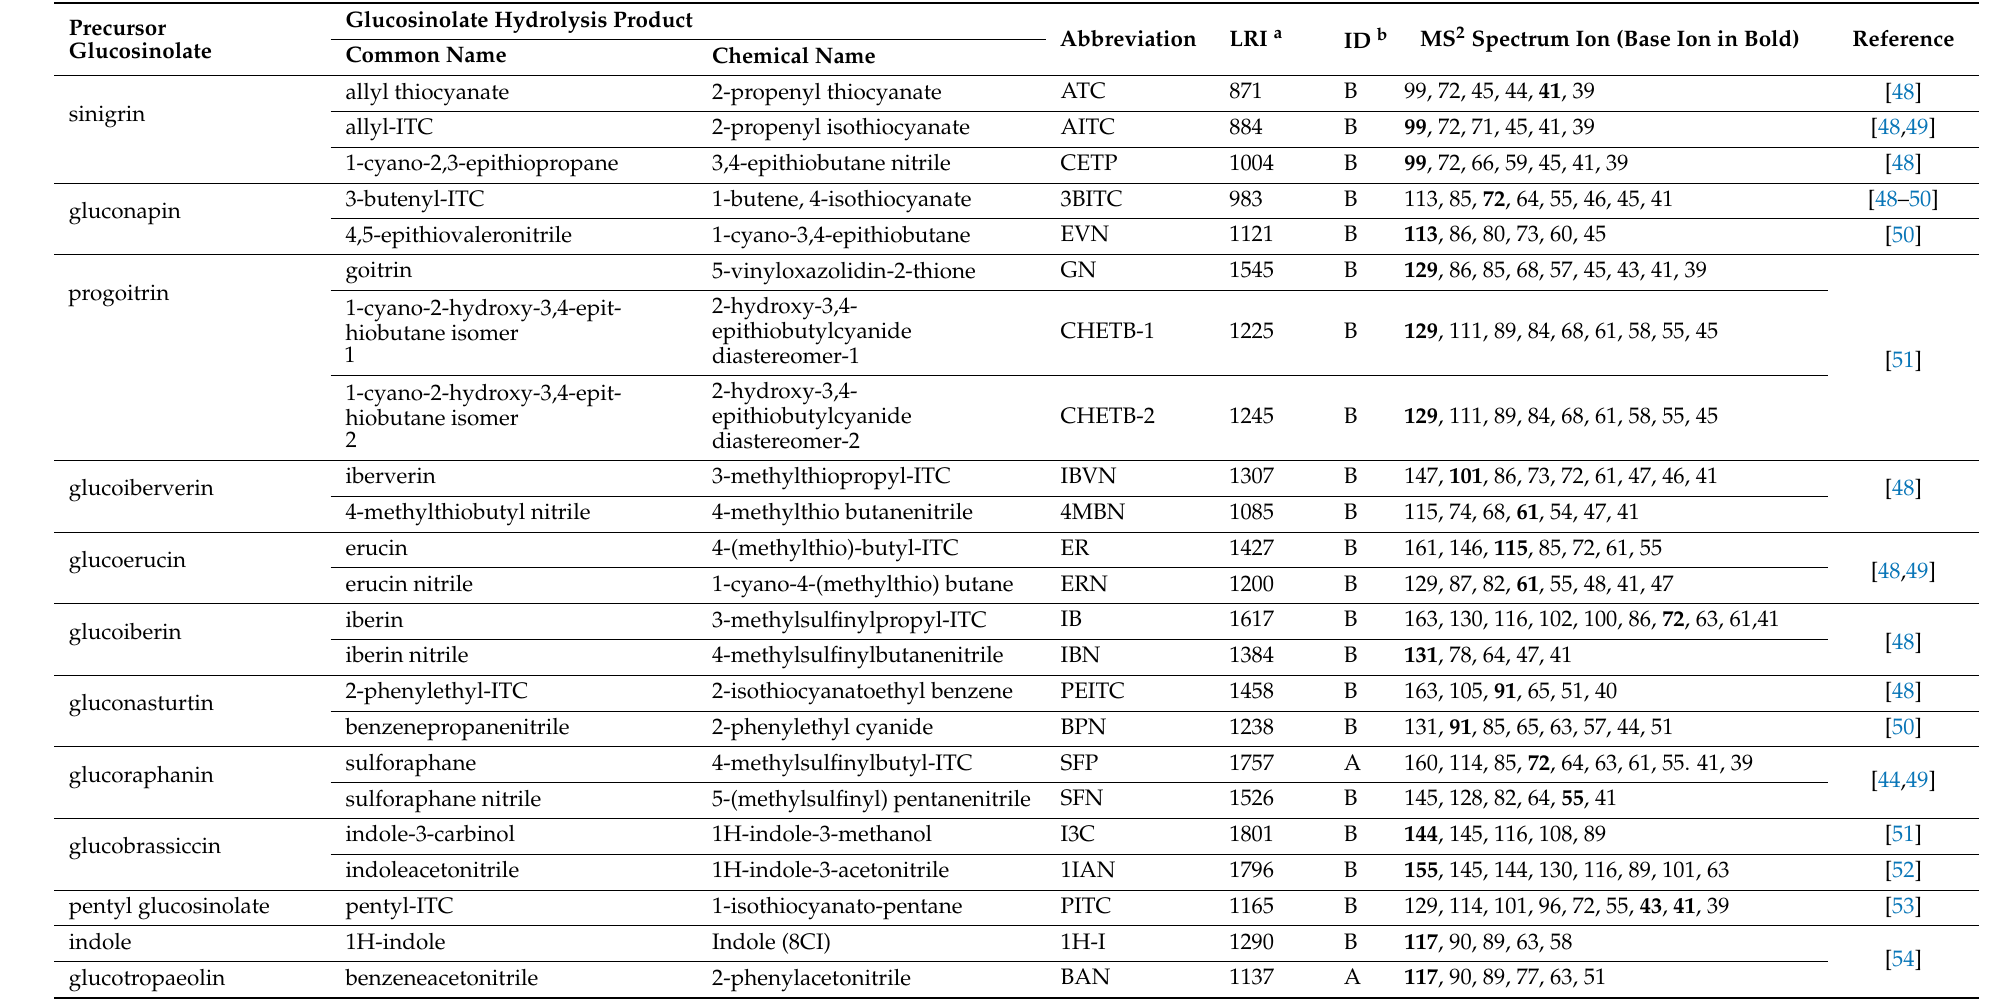
Table 2. Glucosinolate hydrolysis products identified in cabbage accessions analysed by